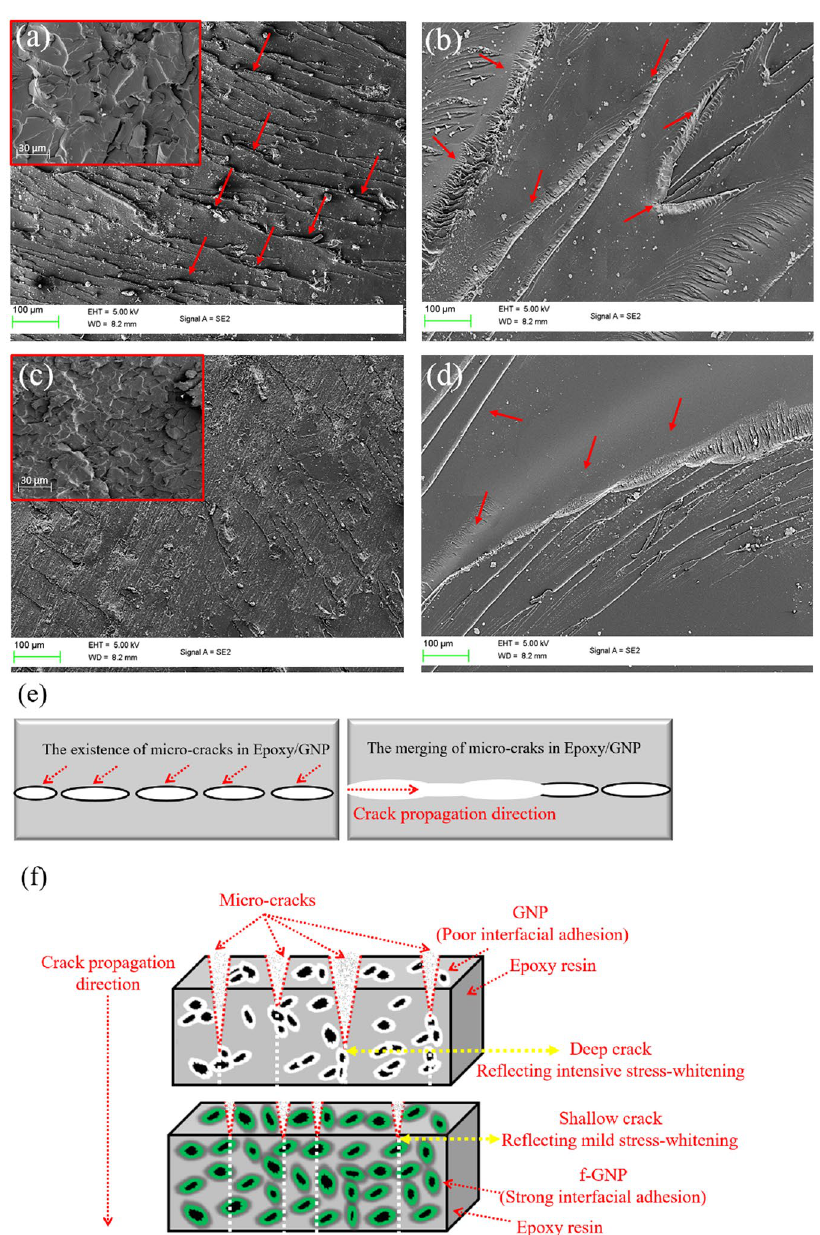
Figure 6. Micro-crack effect and stress-whitening phenomena (red arrows) in SEM images of epoxy/0.5% GNP nanocomposites ( a , b ) and epoxy/0.5% f -GNP nanocomposite at different magnifications ( c , d ) and a schematic of merging of micro-cracks in epoxy/GNP ( e ) and stress-whitening effect ( f ) in